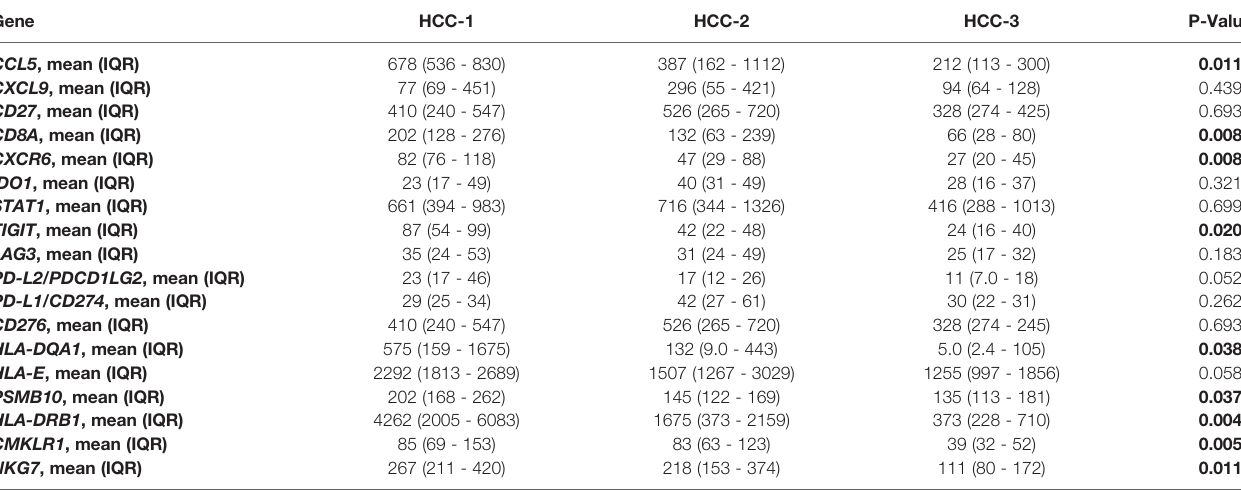
TABLE 4 | Tumor in fl ammation signature by subtype. Gene